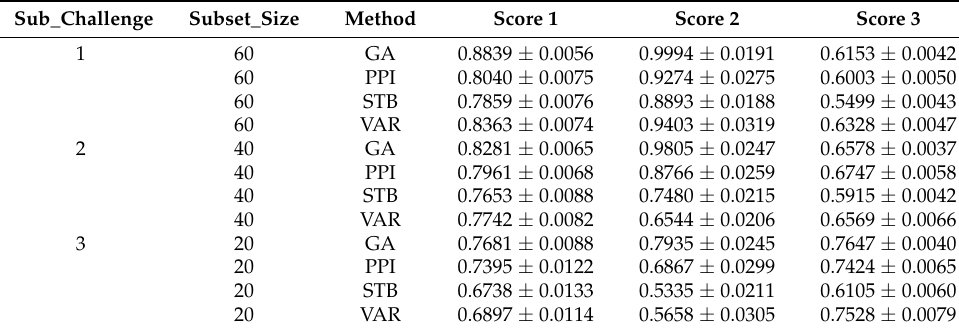
Table 4. Scores of different gene sets after bootstrapping 1000